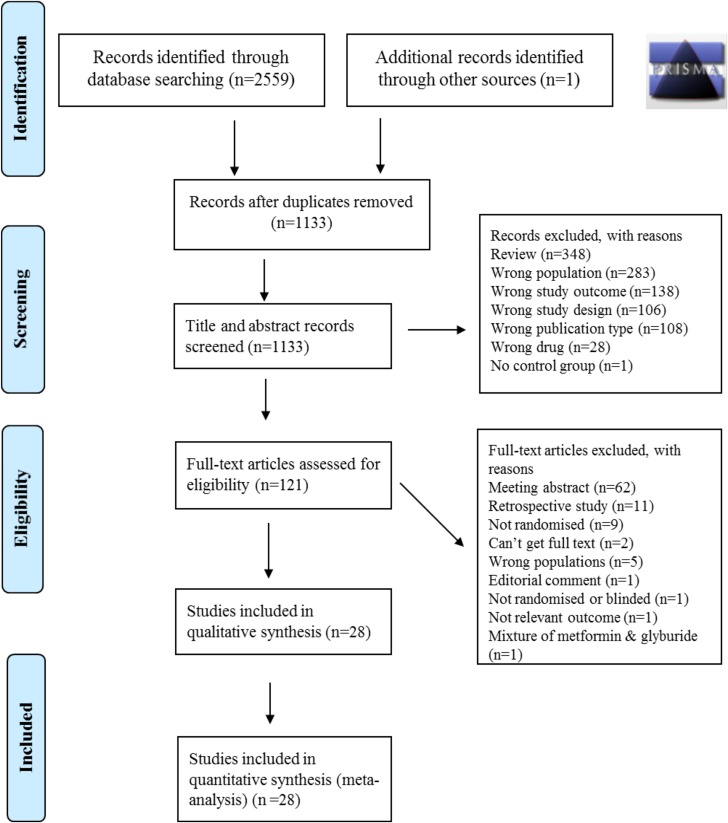
PRISMA flow diagram.